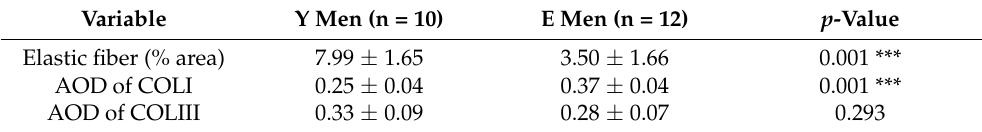
Table 3. The percentage area of the elastic fibers and the AOD (average optical density) of COLI and COLIII in the skeletal muscle of the young and elderly male participants (n =